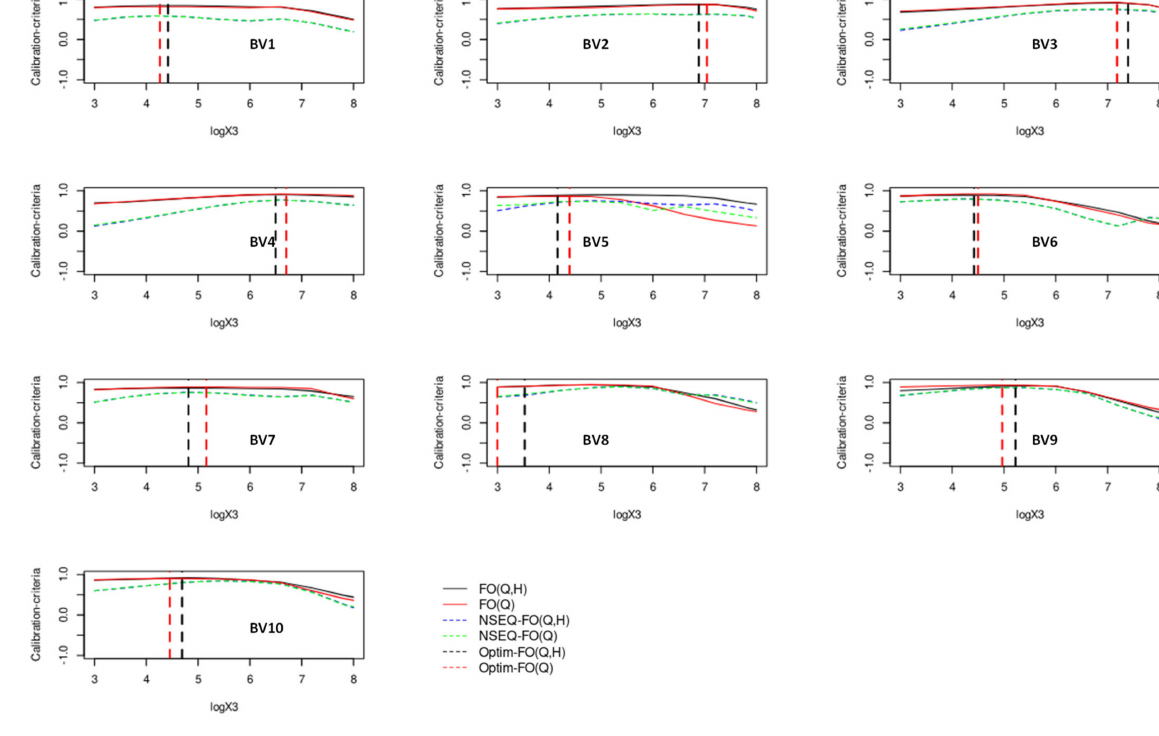
Figure 11. Summary of sensitivity analysis results to the X3 parameter for the GR4J model, with vertical (dotted) lines indicating optimal parameter values for each tested